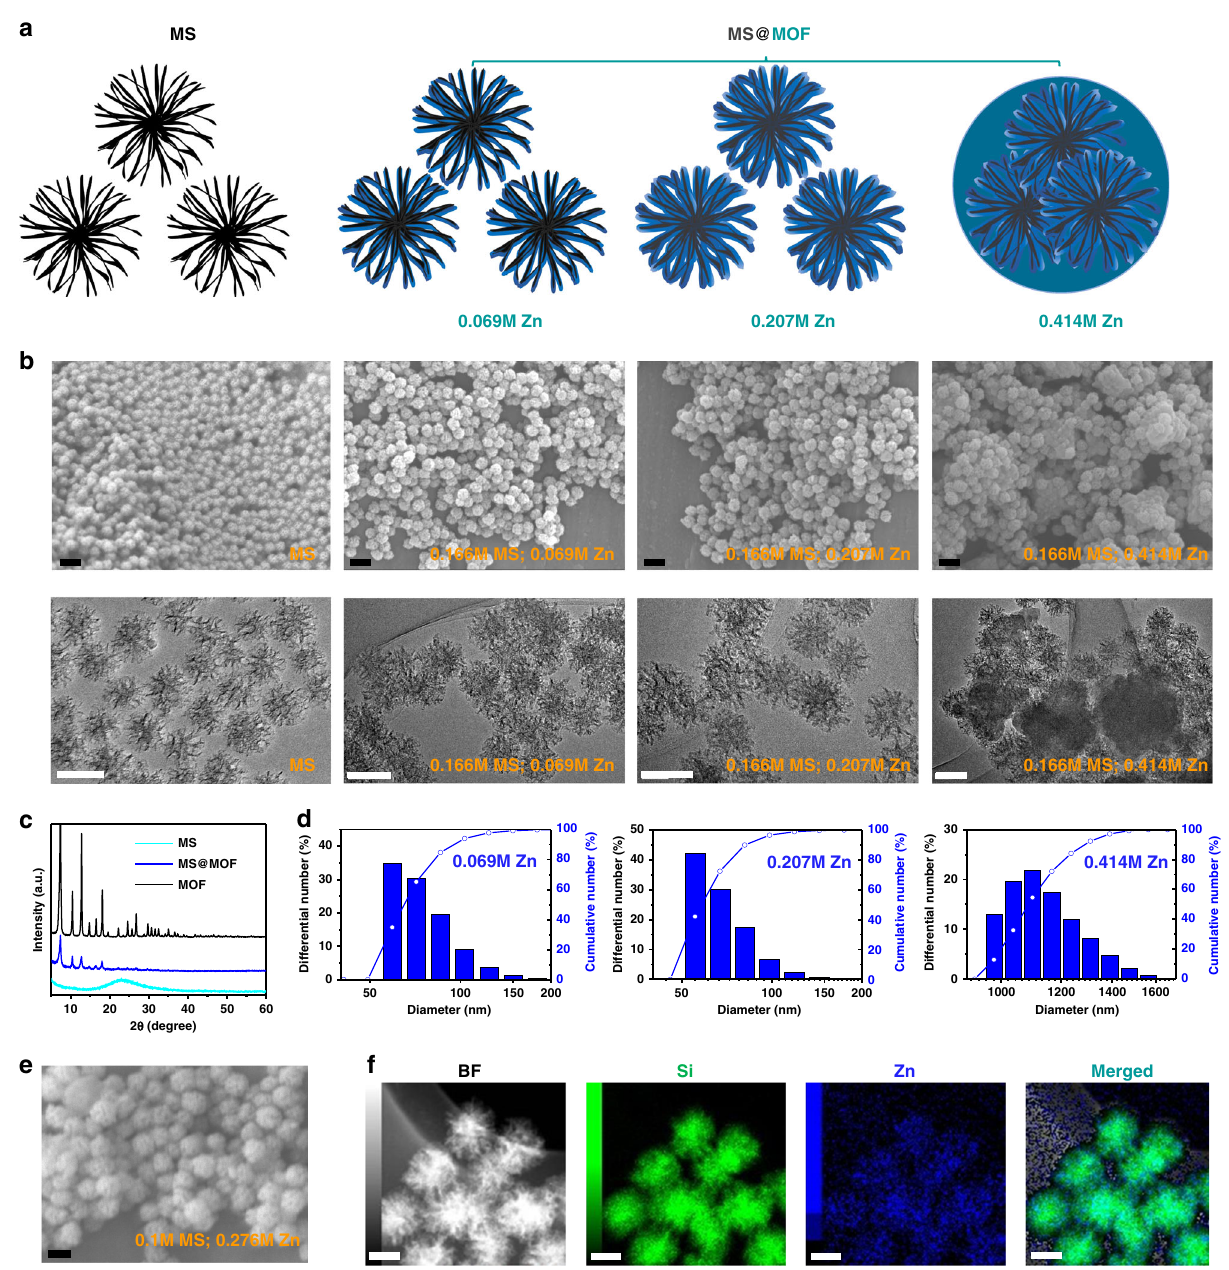
Fig. 1 Hierarchical self-assembling synthesis of MOF-gated MS nanoadjuvants. a Scheme of MS and MOF-gated MS nanostructure, b SEM and TEM images of MS and MOF-gated MS with different ratio of MS/MOF (0.166 M MS, 0.069 M Zn 2 + ; 0.166 M MS, 0.207M Zn 2 + ; and 0.166 M MS, 0.414 M Zn 2 + ). Scale bars, 200 nm (upper, SEM); 100 nm (down, TEM). c XRD patterns of MS, MOF-gated MS and MOF. d Particle size distribution of MOF-gated MS with different ratio of MS/MOF (0.166 M MS, 0.069 M Zn 2 + ; 0.166 M MS, 0.207M Zn 2 + ; and 0.166 M MS, 0.414 M Zn 2 + ). e SEM image and f STEM mapping of MOF-gated MS (synthesis parameter: 0.1 M MS, 0.276 M Zn 2 + ). Scale bar in e , 100 nm. Scale bar in f , 50